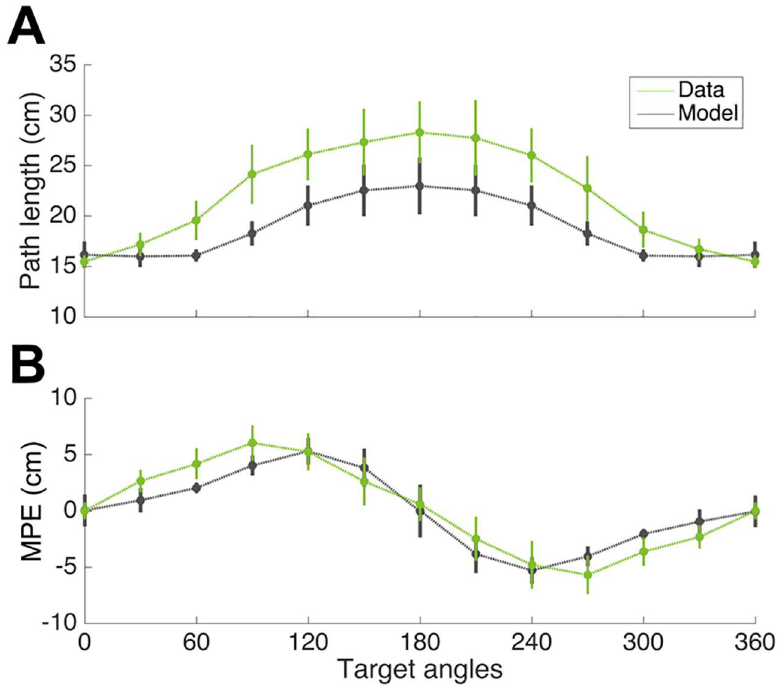
Fig 5. Kinematic attributes of empirical and simulated movements. (A) Path length as a function of movement directionfor empirical(mean across subjects ± s.d.) and simulation(mean ± s.d. from Monte Carlo simulations). (B) As (A) but for MPE (Maximum Perpendicular